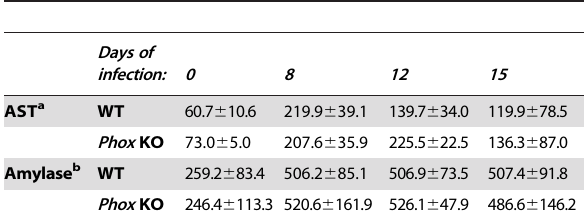
Table 1. Serum AST and amylase in WT and phox KO mice infected with T.